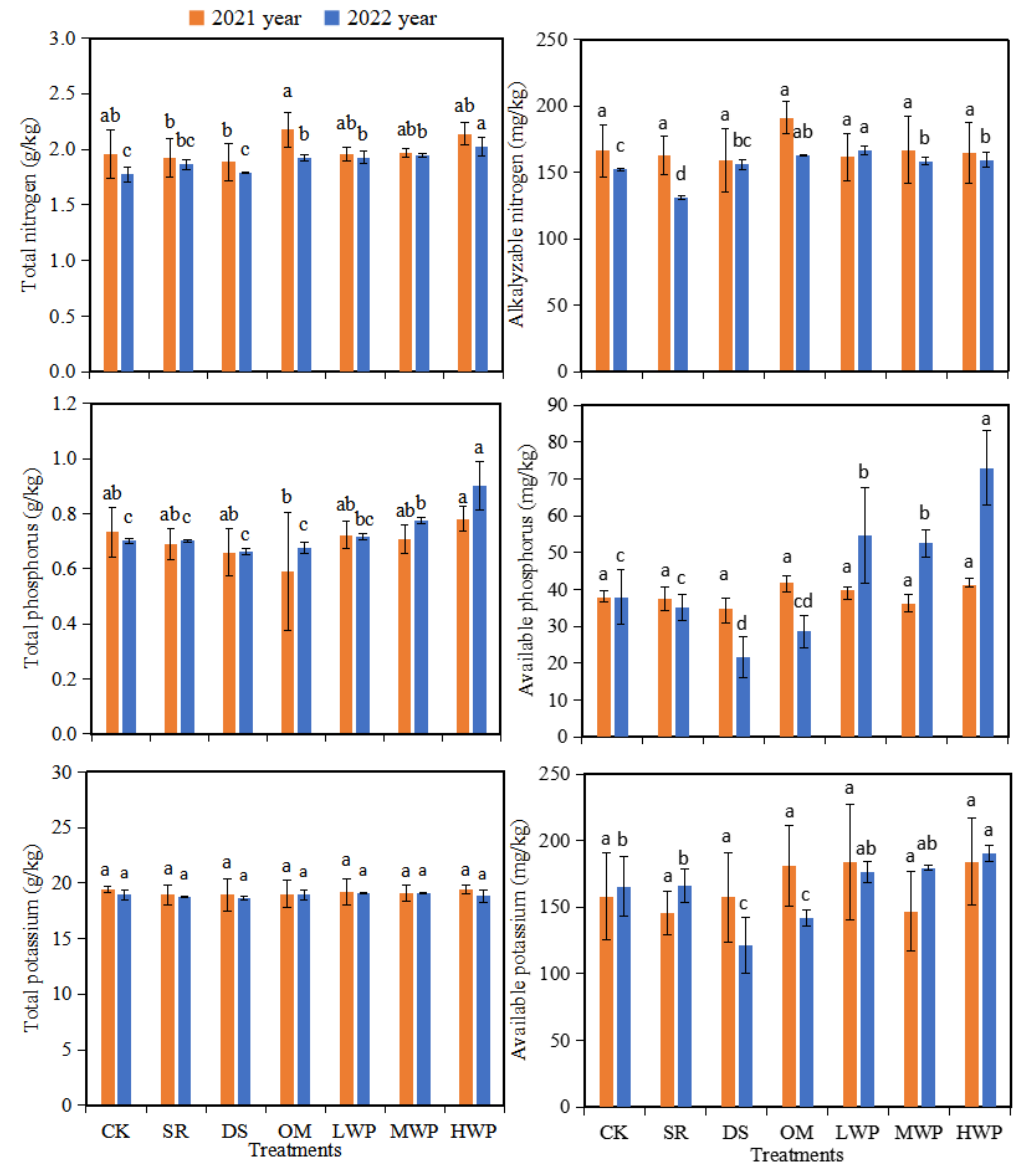
Figure 3. Changes in the total nitrogen (TN), phosphorus (TP), and potassium (TK) contents and the available nitrogen (AN), phosphorus (AP), and potassium (AK) contents in topsoil under different treatments. Different lowercase letters in the same box denote significant differences between different treatments of the same year at p < 0.05, respectively.